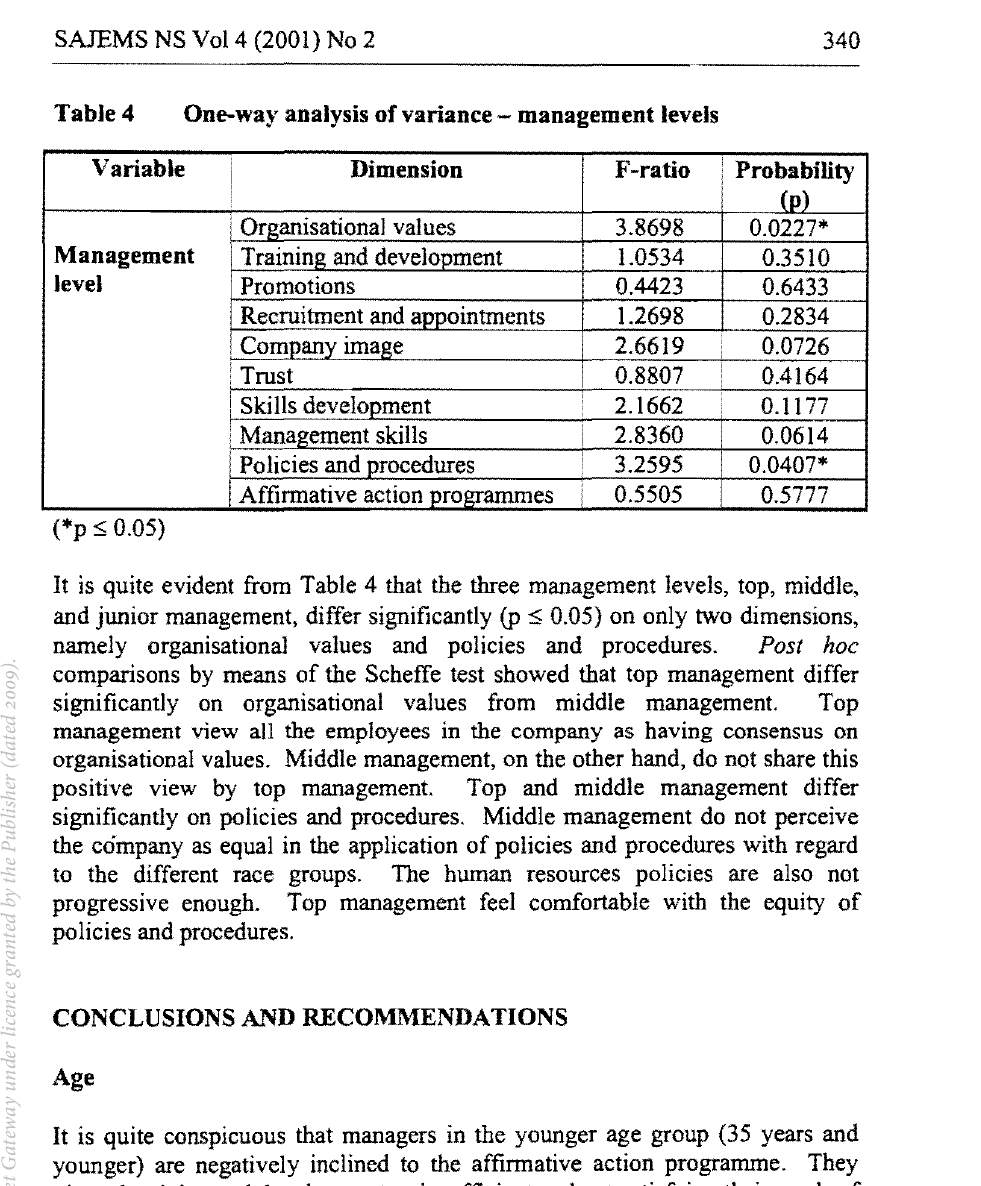
One-way analysis of variance management